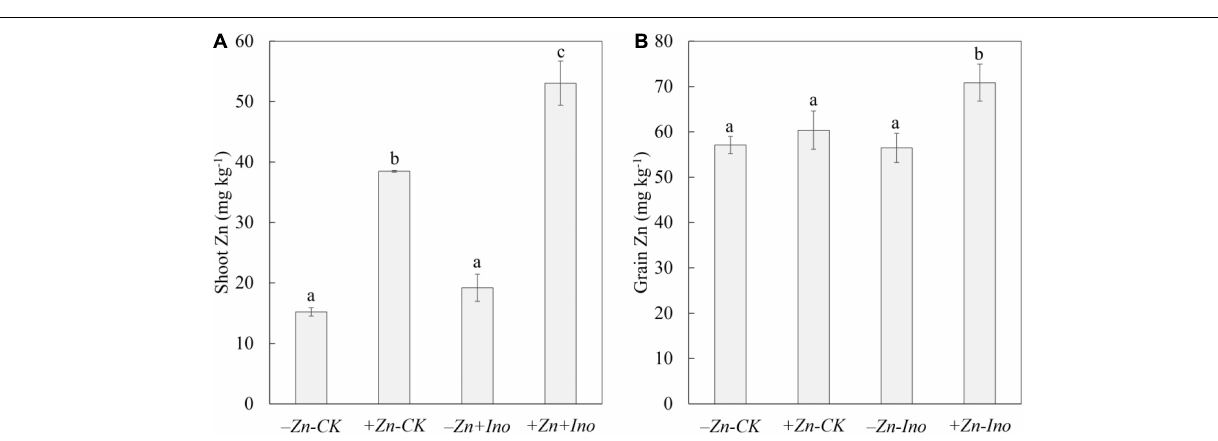
FIGURE 2 | Zinc (Zn) concentrations in shoots (A) and grains (B) of wheat plants treated with different foliar fertilizers. Data points and error bars represent means and SE of four replicates. Different letters denote significant differences ( p < 0.05, n =